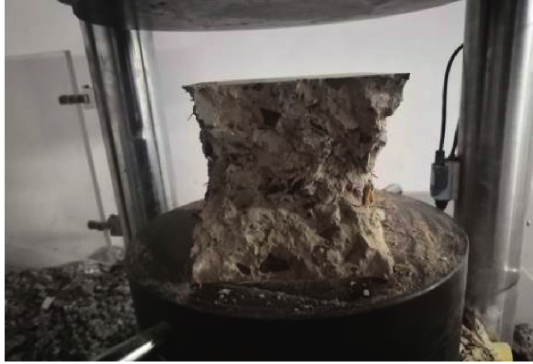
Figure 2: Cube compression test.